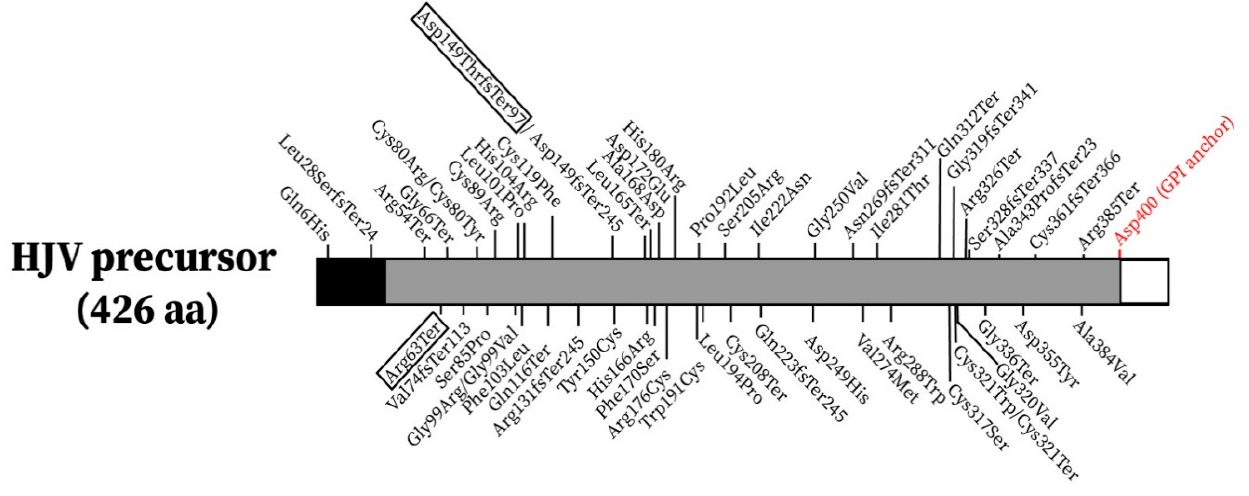
Figure 2. Localization of the reported pathogenic mutations in the HJV precursor. The new mutations reported in this work are boxed. The black region in the N-terminal represents the signal peptide while the white box at the C-terminal represents a portion that will be removed in the maturation process, exposing the Asp400 residue (in red) necessary for the GPI anchor of the HJV protein to the membrane.